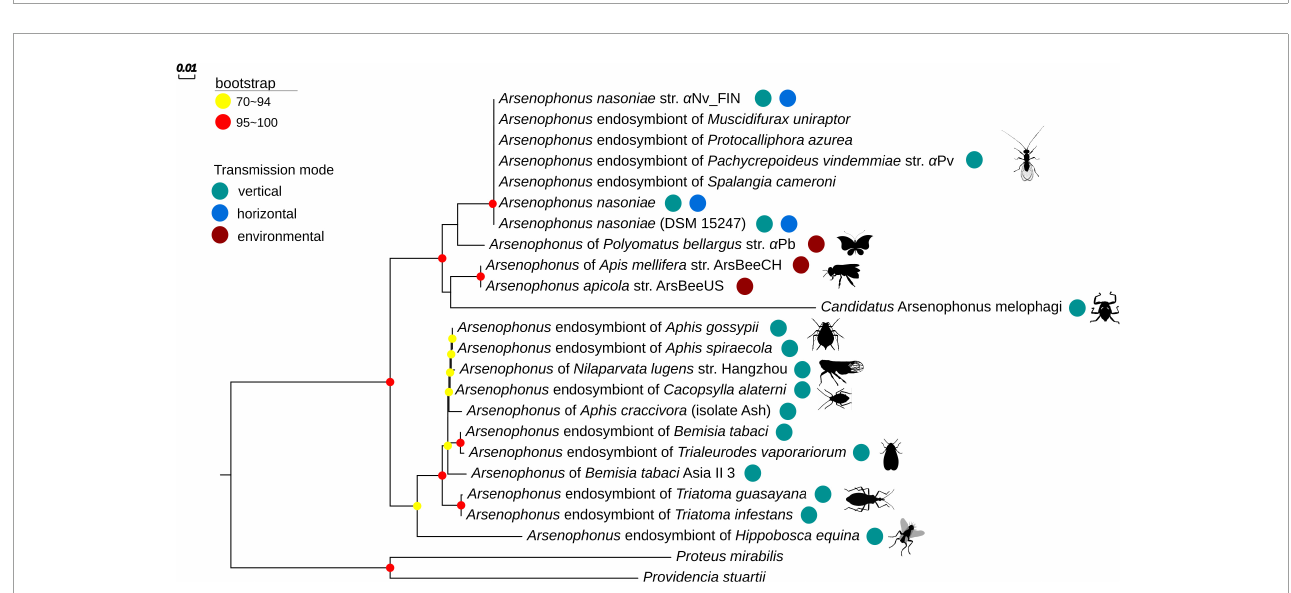
FIGURE3 Estimation of Arsenophonus phylogeny using Maximum Likelihood (ML) based on the concatenated sequences of fbaA, ftsK, and yaeT genes [as in Duron et al. (2010)]. Only bootstrap values higher than 70% are shown (depicted by colored dots on nodes). The phylogenetic tree was constructed using IQTREE and the TN + F + G4 model. Transmission mode of Arsenophonus and stylized insect host are shown next to names. Accession numbers underpinning the phylogeny can be found on figshare (see data availability).